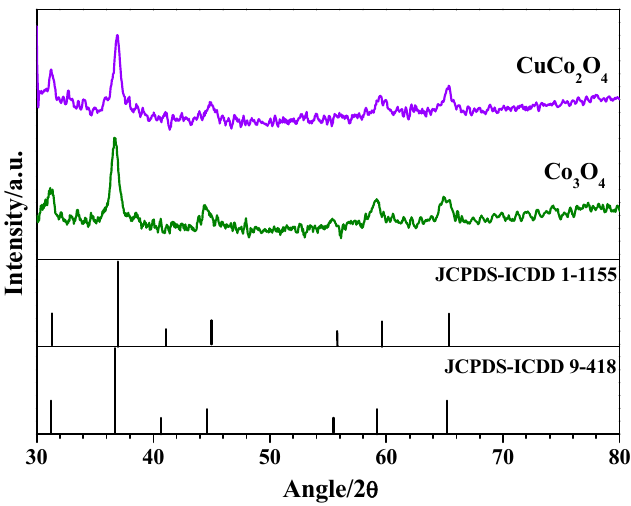
Figure 1. X-ray di ff raction patterns of CuCo 2 O 4 and Co 3 O 4 Figure 1. X-ray diffraction patterns of CuCo 2 O 4 and Co 3 O 4 nanoparticles.